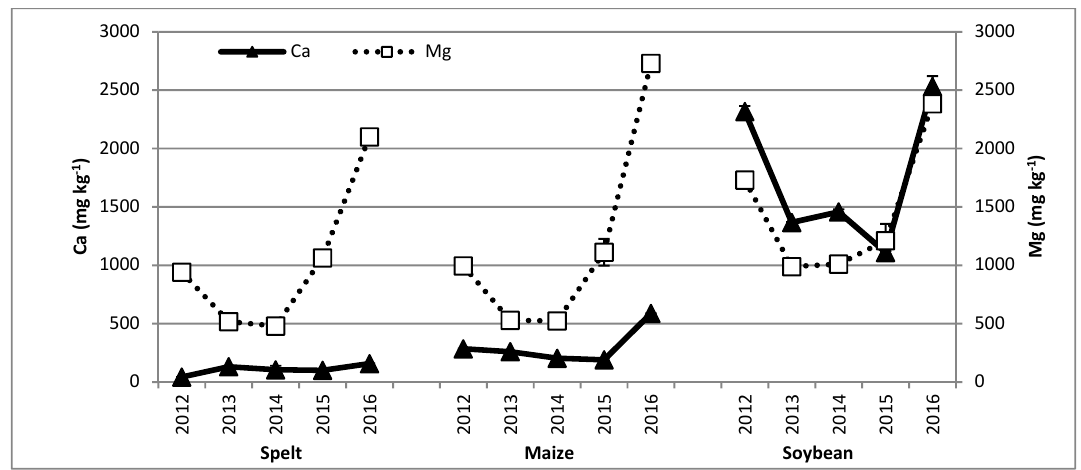
Figure 8. The variation of Ca and Mg concentration in grain of organically producedspelt, maize, and soybean (bars represent SD values).